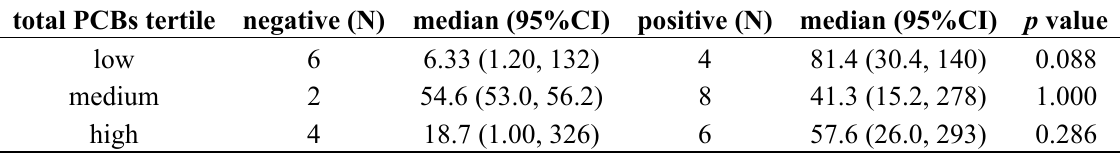
Table 3A. Association between egg specific IgE and IL-22 as analyzed by total PCBs tertile groups.